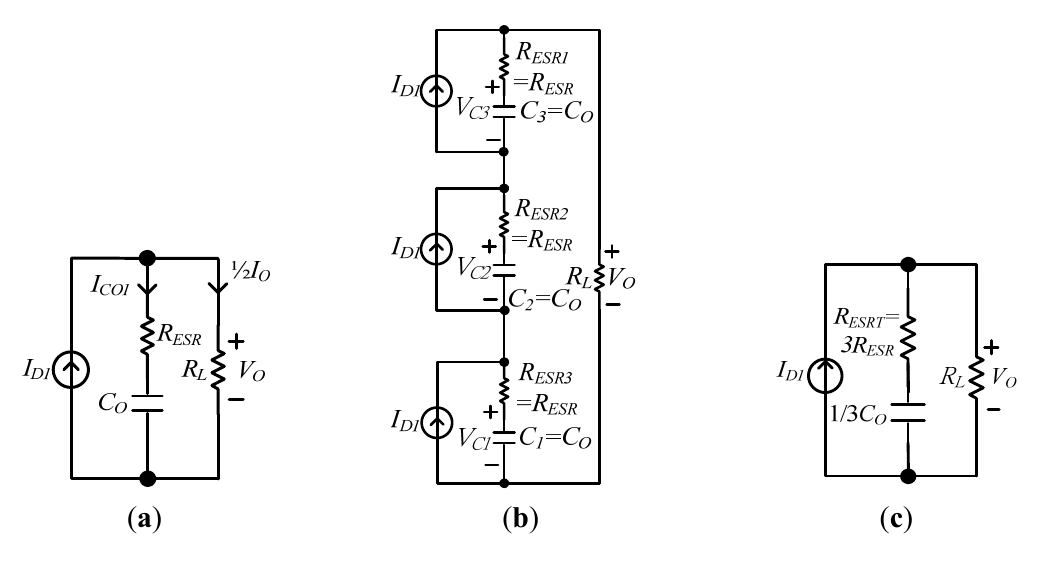
Figure 29. Equivalent circuit of output terminals: ( a ) the proposed converter; ( b ) the conventional converter proposed in [29]; and ( c ) the simplified conventional converter proposed in